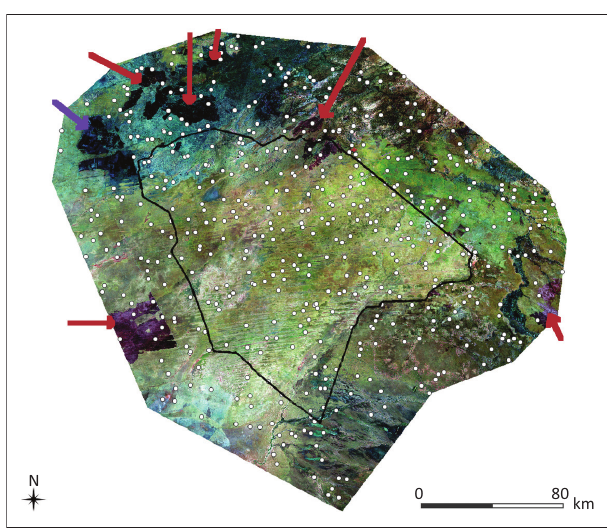
FIGURE 1-A2: Simple random sampling points used in accuracy assessment and visible burn scars. Landsat 8 Operational Land Imager (OLI) image, bands RGB654, of the late 2013 dry season showing the 500 randomly distributed validations points (white dots), recent burn scars (indicated by red arrows), what is probably an agricultural area (purple arrow), and the location of small town of Dete used as an example of unclassified condition in Figure 2 (tiny red cross at edge of the north-east boundary of Hwange National